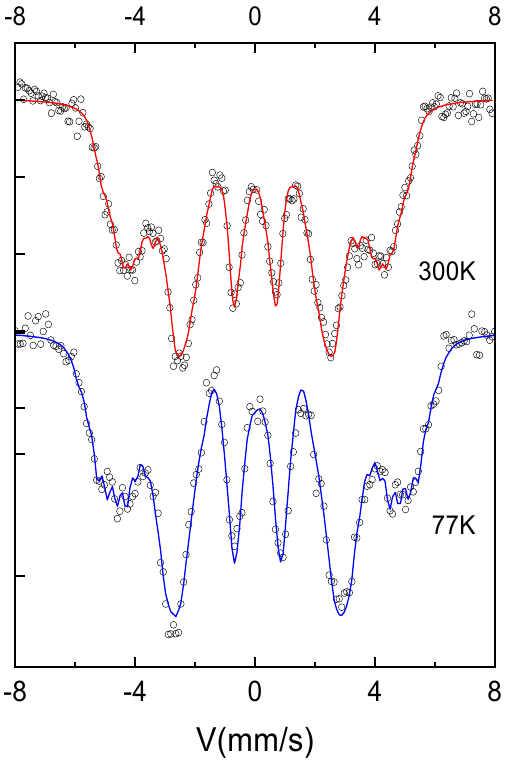
Figure 2. 300K and 77K Mössbauer spectra of as-cast Fe 65 Pt 15 Zr 3 B 17 sample.